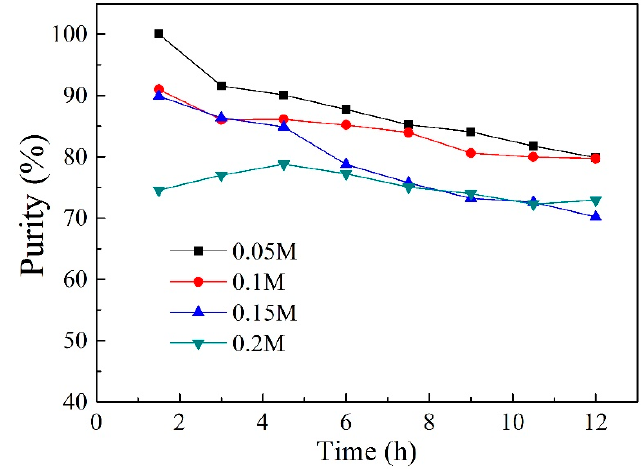
Figure 11. Effect of HCl concentration on the purity of hexanoic acid (PIMs: PIM4; Feed solution: 0.01 mol L − 1 acetic acid +0.01 mol L − 1 hexanoic acid, pH = 6; Stripping solution: 0.05, 0.1, 0.15, and 0.2 mol L − 1 HCl).